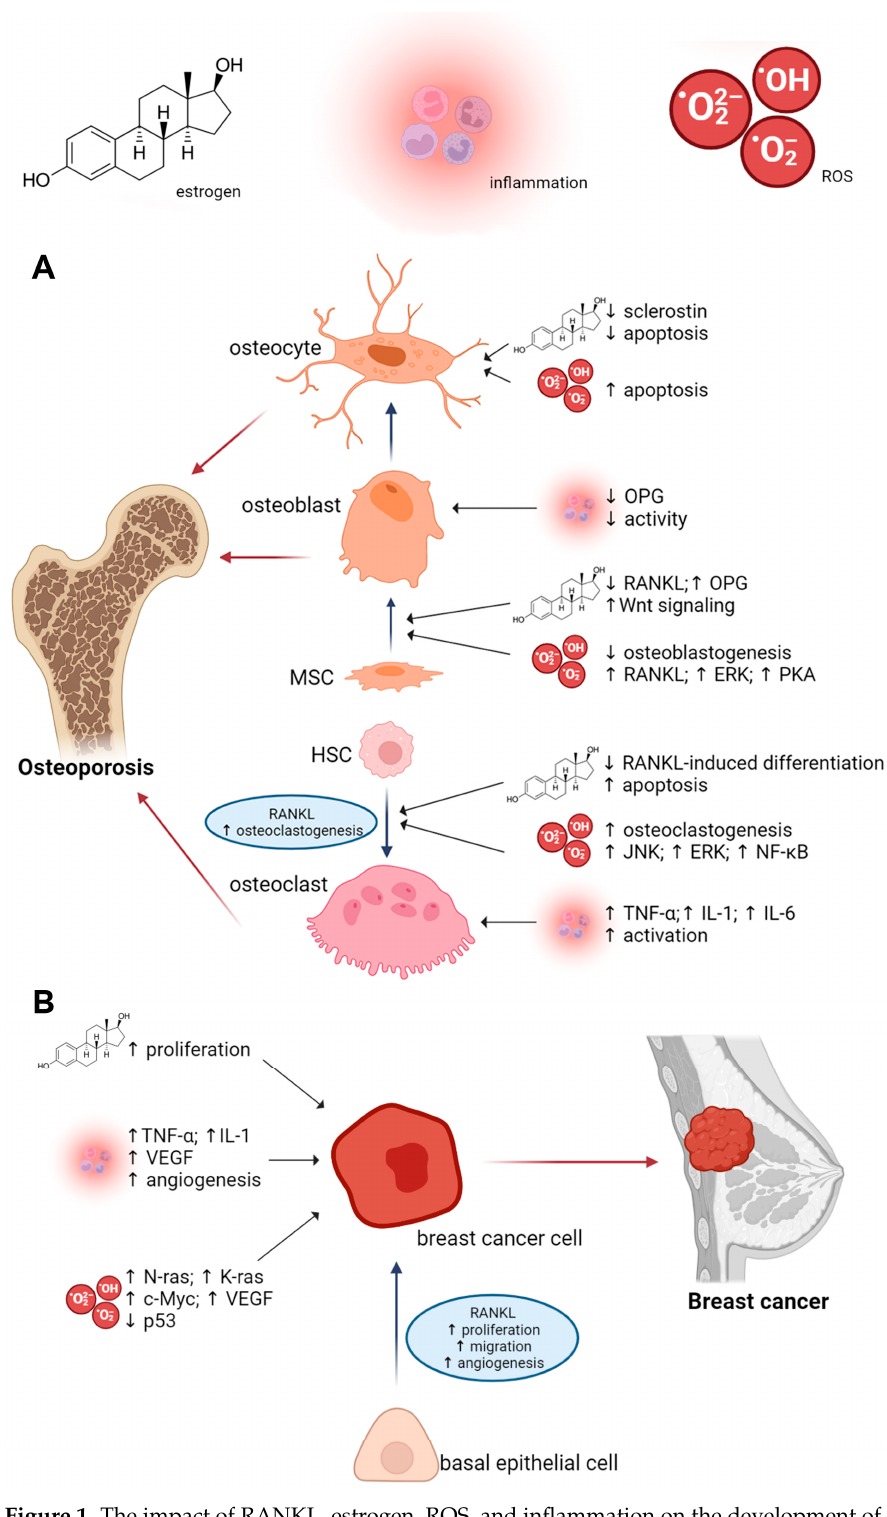
Figure 1. The impact of RANKL, estrogen, ROS, and inflammation on the development of osteoporo- sis ( A ) and breast cancer ( B ) (created with BioRender.com, https://www.biorender.com/, accessed on 27 January 2023). Abbreviations: c-Myc—c-myelocytomatosis oncogene product; ERK—extracel- lular signal-regulated kinase; HSC—hematopoietic stem cell; IL-1—interleukin 1; IL-6—interleukin